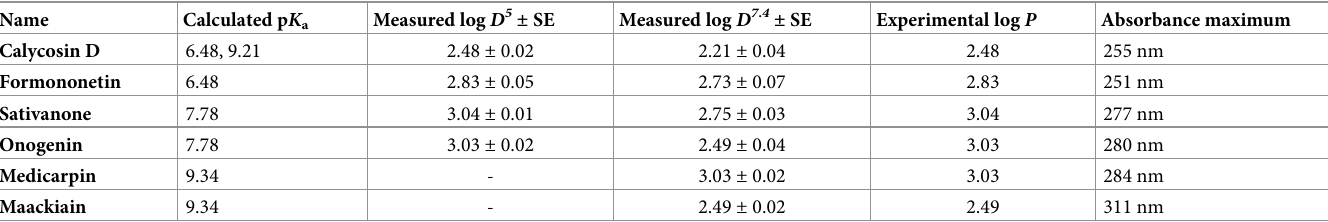
Table 1. The calculated p K a values, experimental log D pH and log P values and wavelength used during the measurements of the six isoflavonoids.